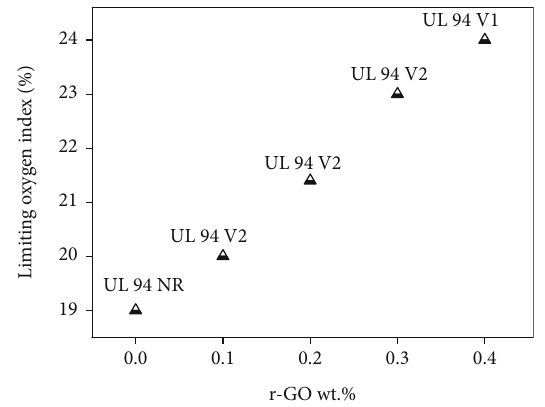
Figure 7: Limiting oxygen index and vertical fl ammability ranking of